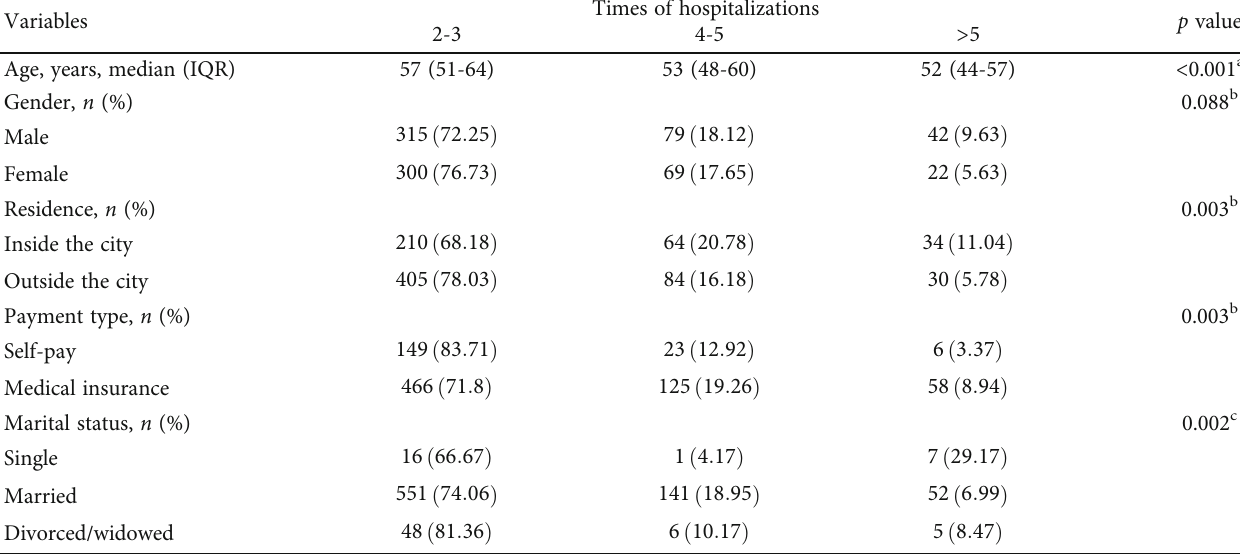
Table 2: Comparison of characteristics in patients with di ff erent times of hospitalizations.